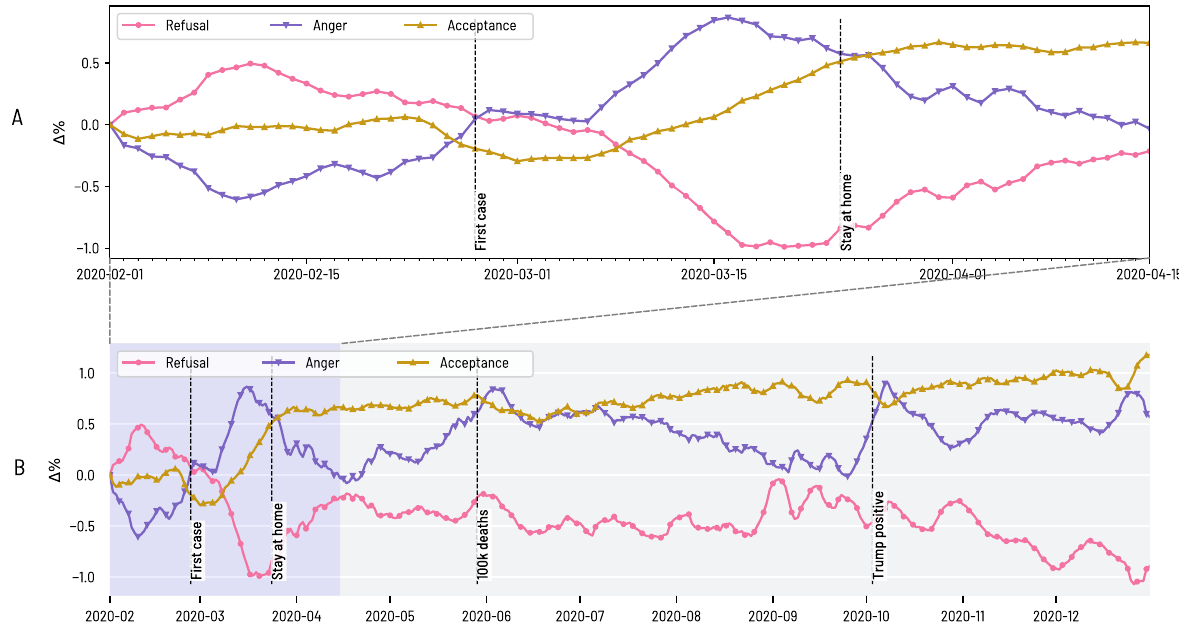
Fig. 3 Aggregated measures of the three phases of Epidemic Psychology over time. The evolution of the language categories associated with refusal , of those associated with anger , and of those associated with acceptance , zooming out from the fi rst contagion wave ( A ) to the three waves during the entire 2020 ( B